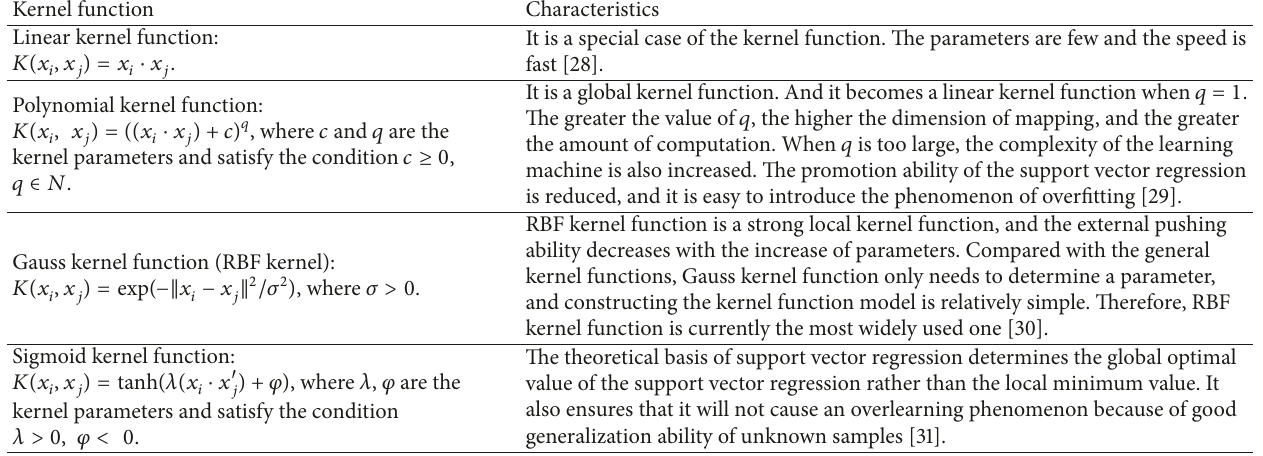
Table 1: Four types of kernel functions and their characteristics. Kernel function